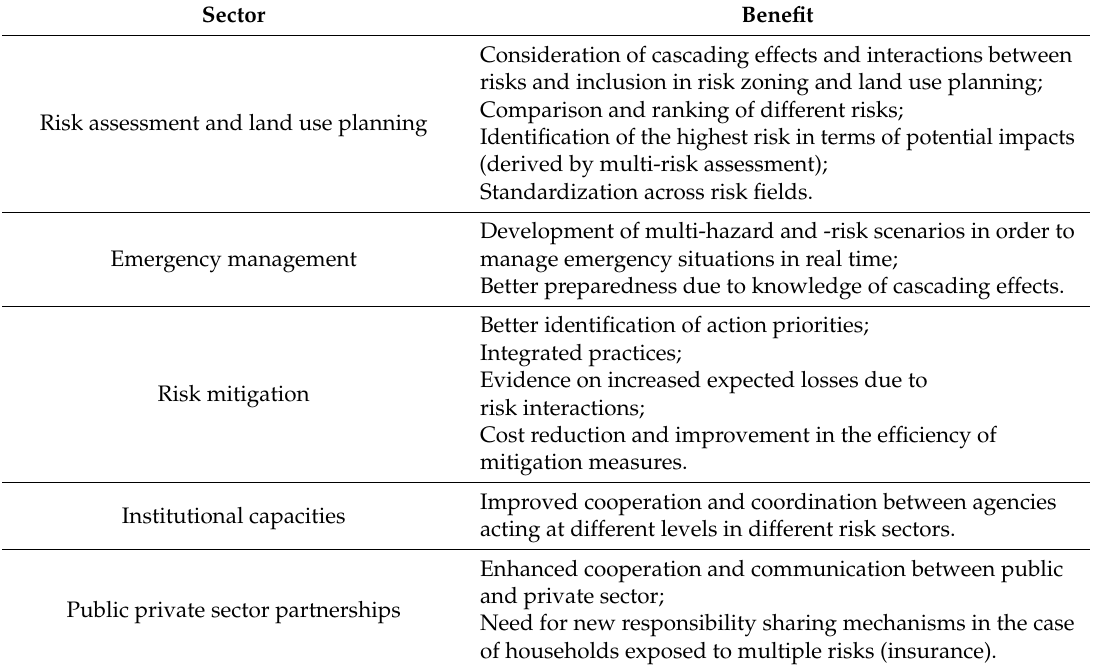
Table 1. Governance benefits derived by adoption of a multi-risk approach